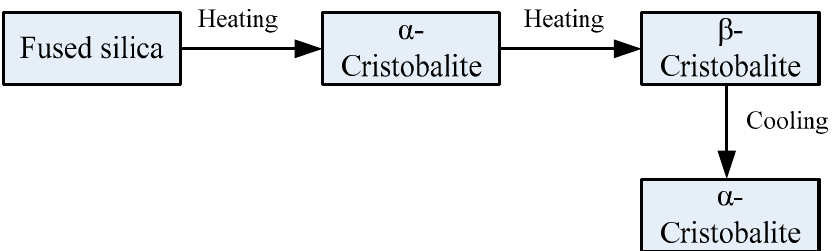
Figure 7. The crystal transformation in the fiber during the process of heating and cooling.